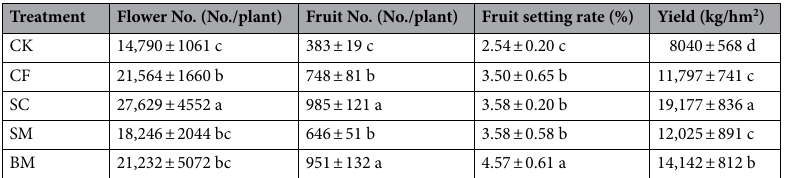
Table 5. Effects of different fertilizer treatments on reproductive growth of Pear-jujube. The data are the mean ± standard deviation of the parameters in this group. At different levels, each population mean follows a normal distribution with the same variance. The LSD least significant difference method was selected for analysis of variance in DPS software. Different lowercase letters in the same column indicate significant difference between treatments ( P <